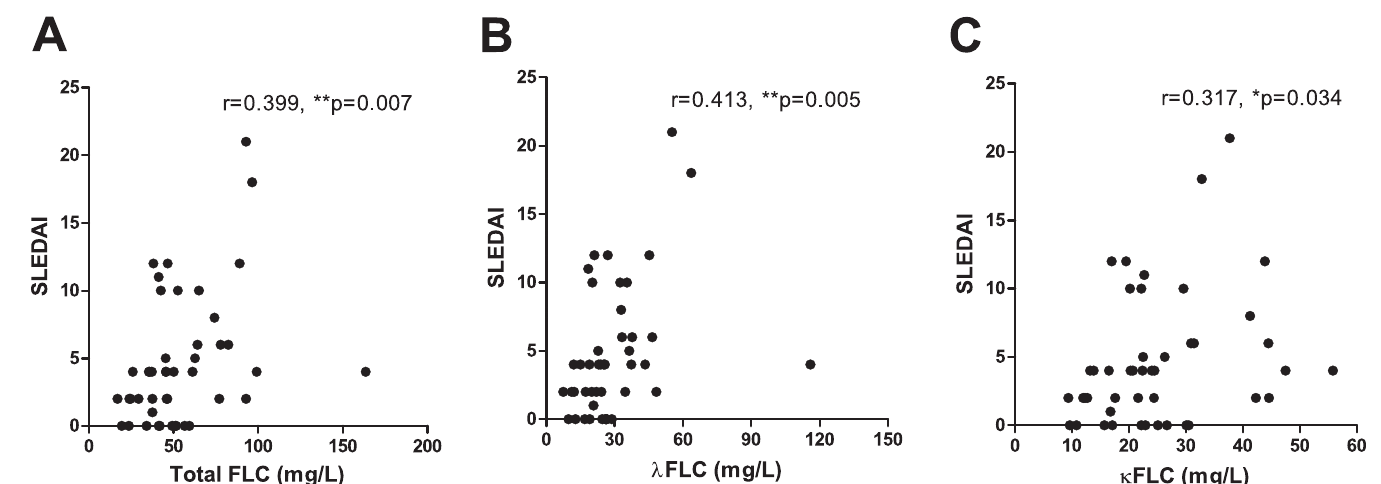
Fig 2. Correlation between serum FLC concentrations and SLEDAI scores of SLE patients. Correlation between SLEDAI scores and total FLC (A), λ FLC (B) and κ FLC (C) levels in SLE patients (n = 45). r-values are 0.399 (p = 0.007), 0.413 (p = 0.005) and 0.317 (p = 0.034) in A, B and C, respectively. FLCs — free light chains, SLE — systemic lupus erythematosus, SLEDAI — SLE disease activity index.